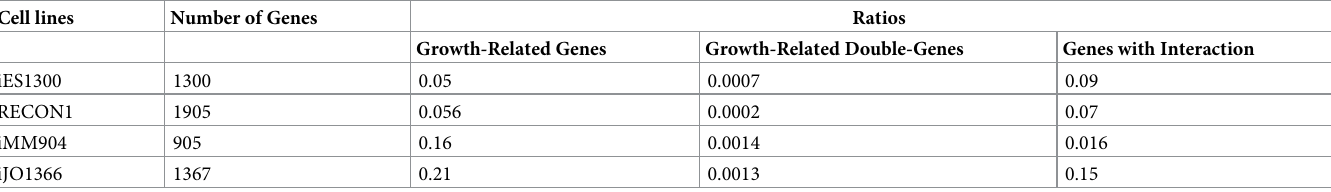
Table 1. Results of single and double gene deletion analysis on four metabolic models using FBA approach. Cell